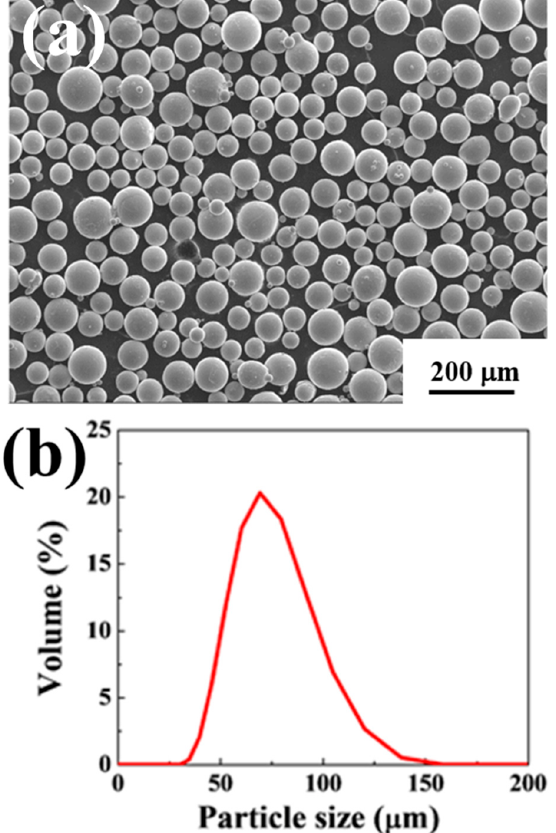
Figure 3. ( a ) SEM micrograph of the Ti6Al4V gas-atomized powders; and ( b ) the particle size distribution of the as-atomized